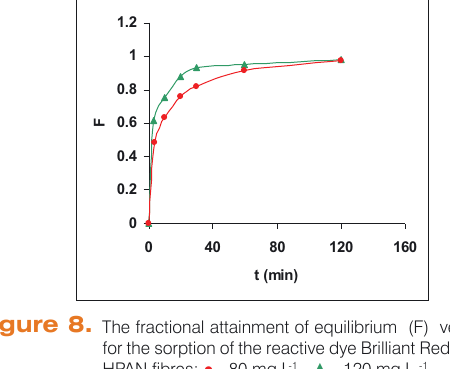
Figure 8. The fractional attainment of equilibrium (F) versus time for the sorption of the reactive dye Brilliant Red HE-3B on HPAN fibres; ● - 80 mg L -1 , ▲ - 120 mg L -1 .